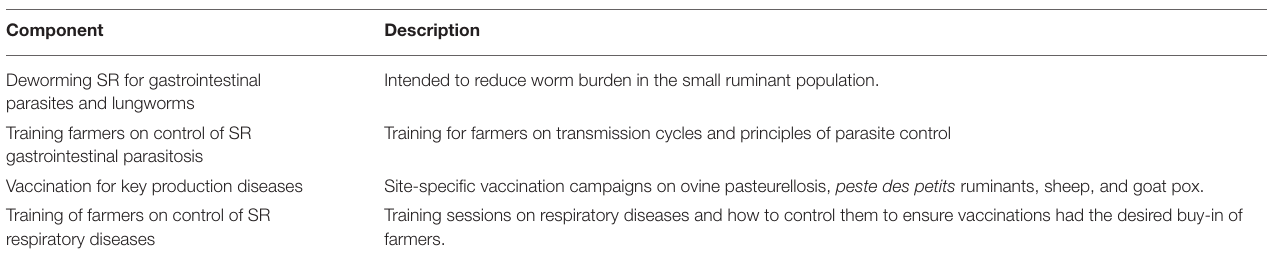
TABLE 2 | Description of the components of the small ruminant health intervention. Component Description Deworming SR for gastrointestinal Intended to reduce worm burden in the small ruminant parasites and lungworms